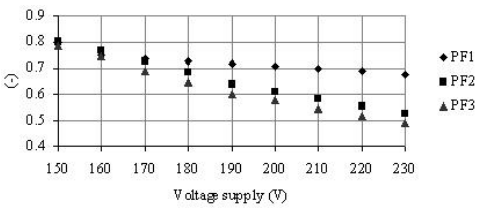
Figure 8. Power factors PF 1 , PF 2 , and PF 3 on each phase (a, b, c) depending on the supply voltages (set 1).